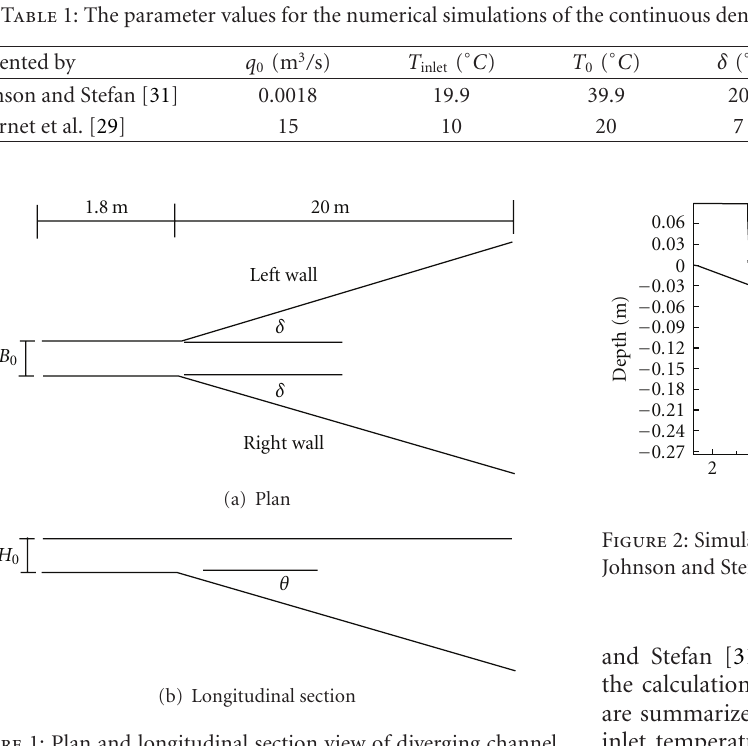
Figure 1: Plan and longitudinal section view of diverging channel with sloping bottom at the experiment of Johnson and Stefan [31].